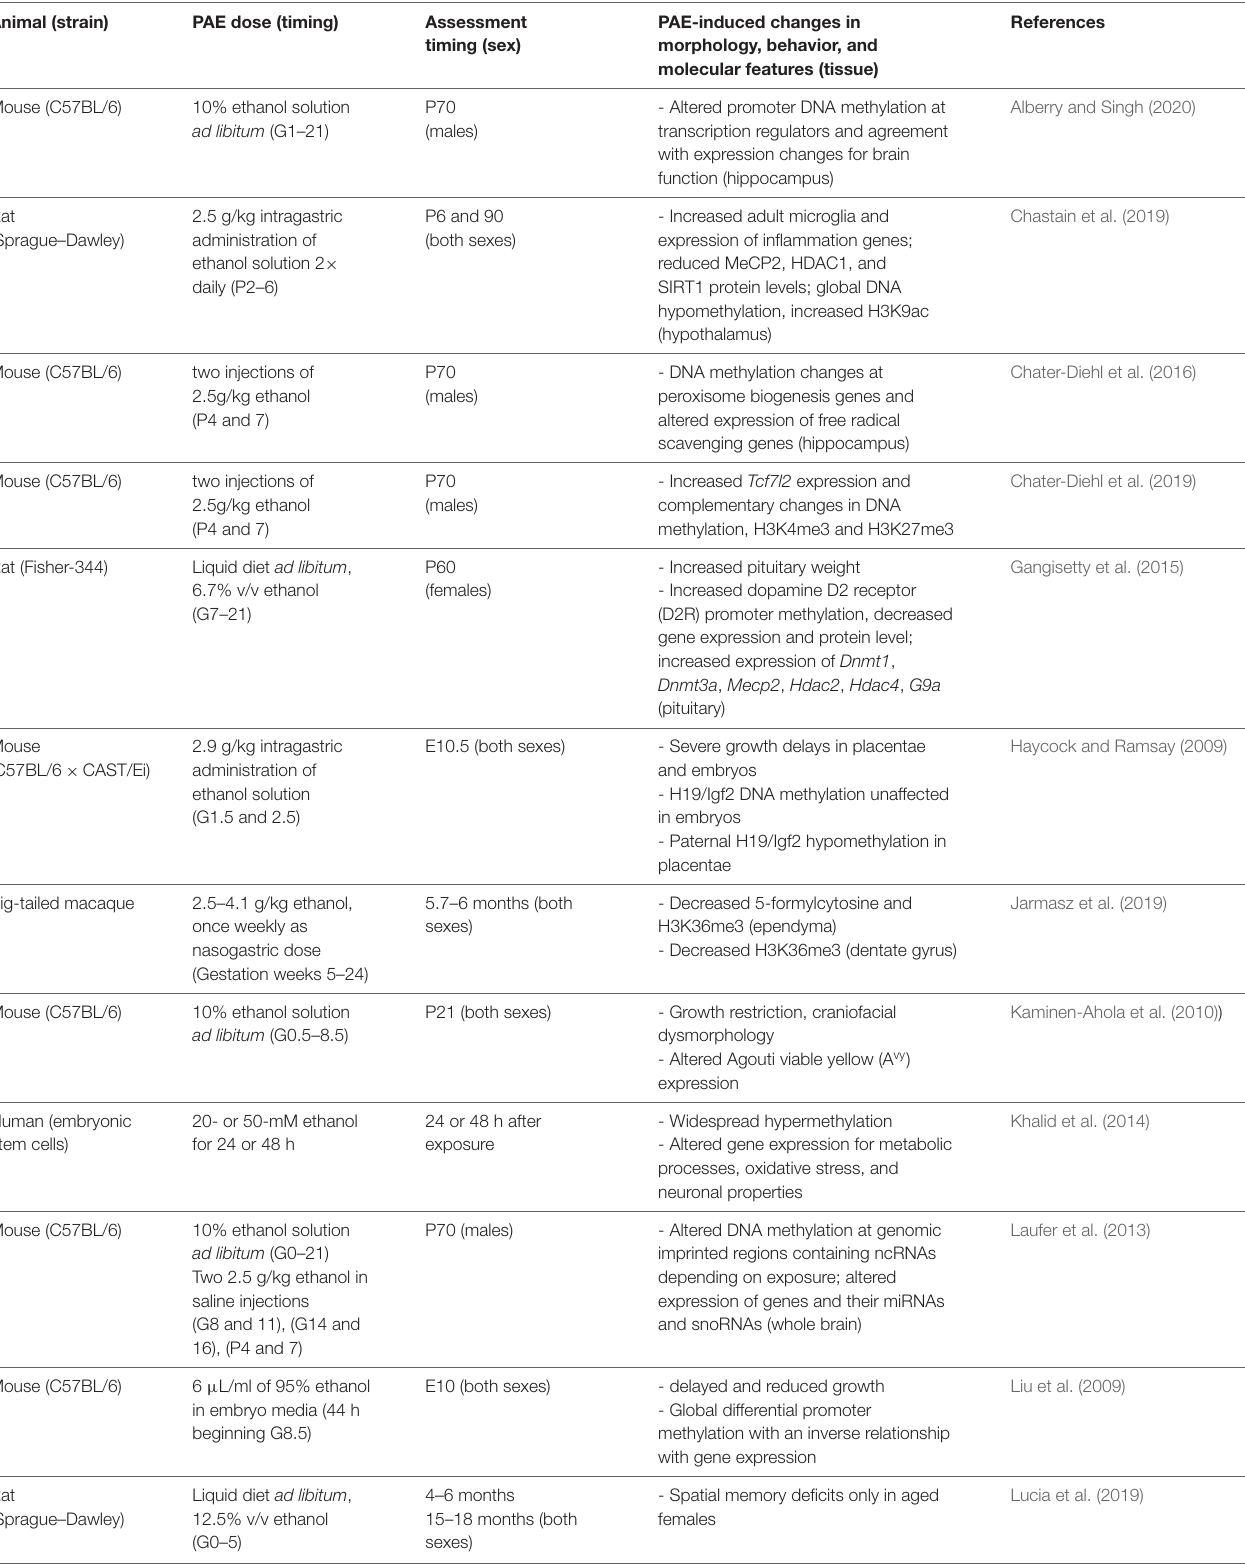
TABLE 2 | Summary of animal models of FASD that investigate miRNAs, DNA methylation, and histone post-translational modifications in the literature. Animal